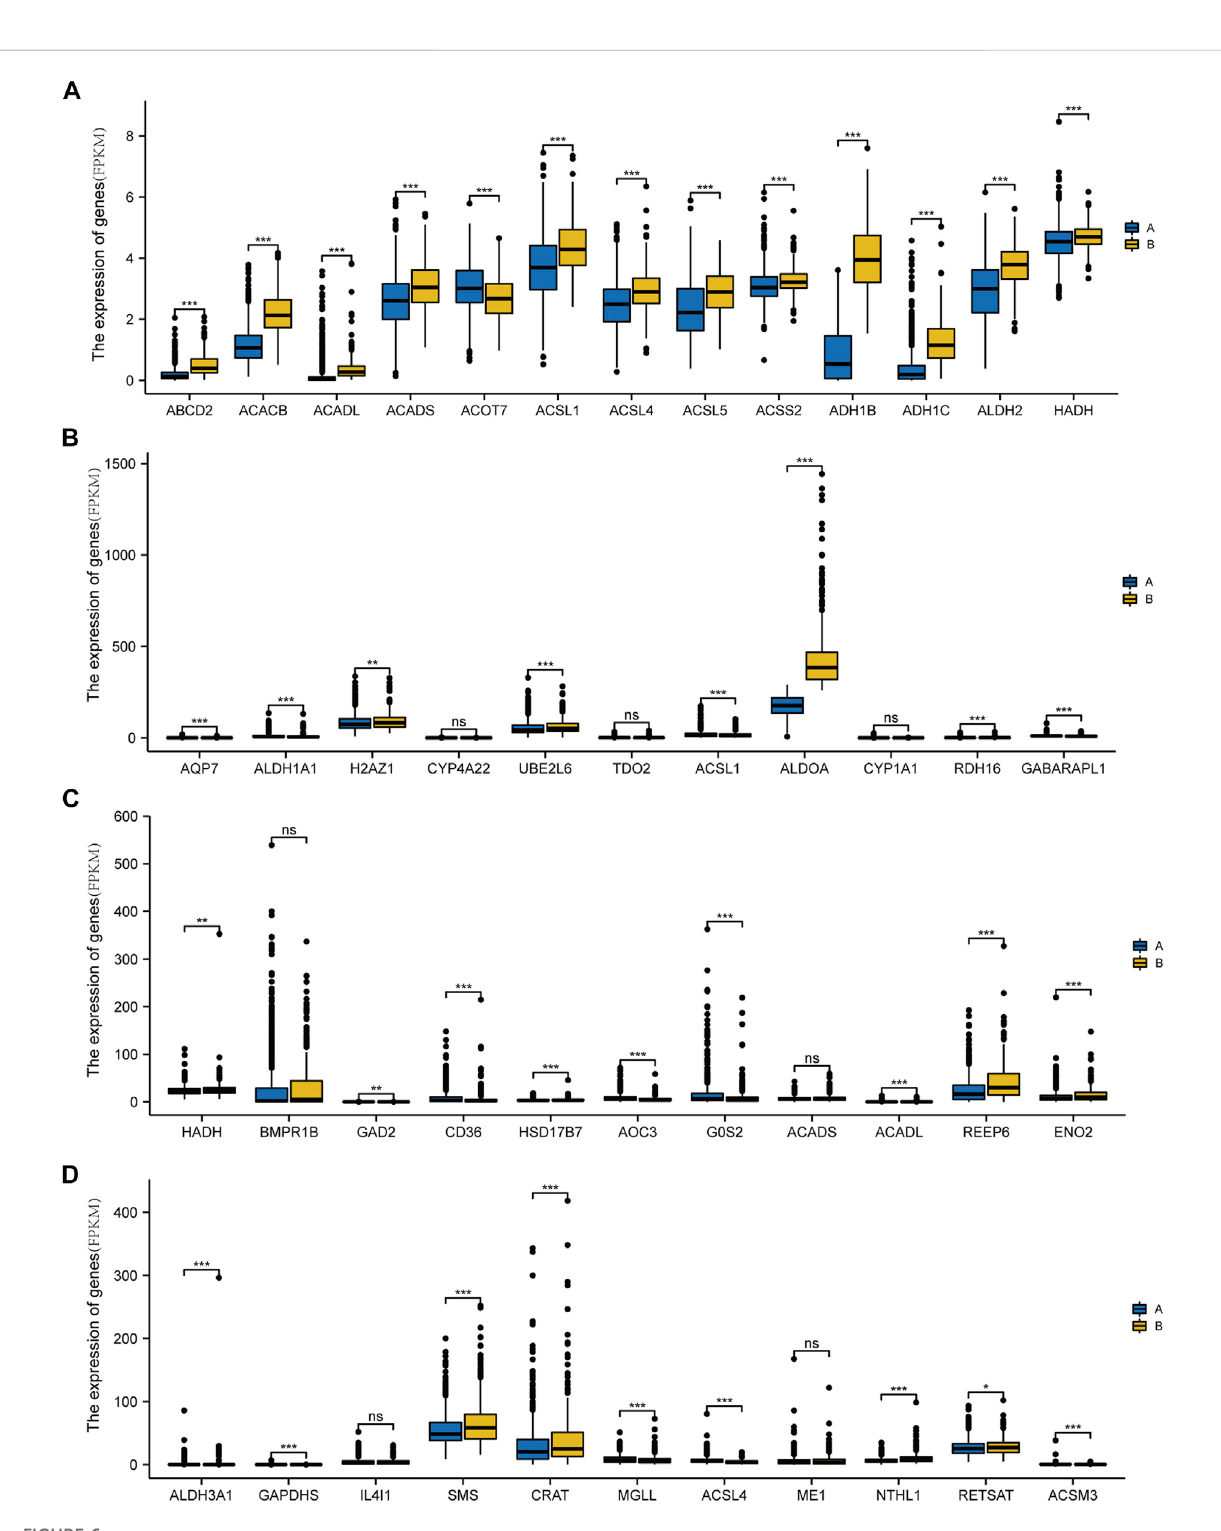
FIGURE 6 Differential expression of genes involved in fatty acid metabolism in different types of breast cancer. (A) Expression of ADH1C , NMT , MIF , HSD17B11 , MAOA , PPARA , CIDEA , CEL , ECI1 , GPD1 , and CA4 in breast cancer subtype A and B groups. (B) Expression levels of AQP7 , ALDH1A1 , H2AZ1 , CYP4A22 , UBE2L6 , TDO2 , ACSL1 , ALDOA , CYP1A1 , RDH16 , and GABARAPL1 insubtypeA andBgroups ofbreastcancer. (C) Exportof HADH , BMPR1B , GAD2 , CD36 , HSD17B7 , AOC3 , G0S2 , ACADS , ACADL , REEP6 , and ENO2 in subtype A and B groups of breast cancer. (D) ALDH3A1 , GAPDHS , IL4I1 , SMS , CRAT , MGLL , ACSL4 , ME1 , NTHL1 , RETSAT , and ACSM3 expression in the breast cancer subtype A and B groups. (ns, p ≥ 0.05; *, p < 0.05; **, p < 0.01; ***, p <